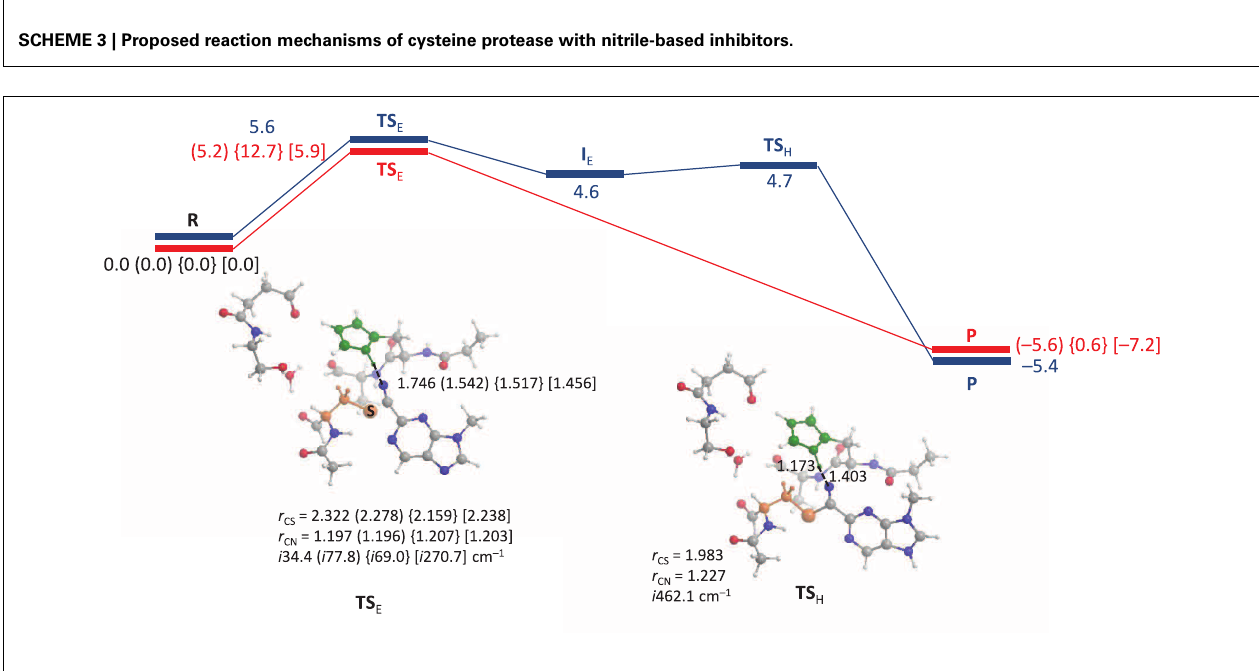
angstroms, the imaginary frequency in the transition states in cm − 1 and relative energies ( (cid:2) E + ZPE with energies calculated with basis set B2) in kcal mol − 1